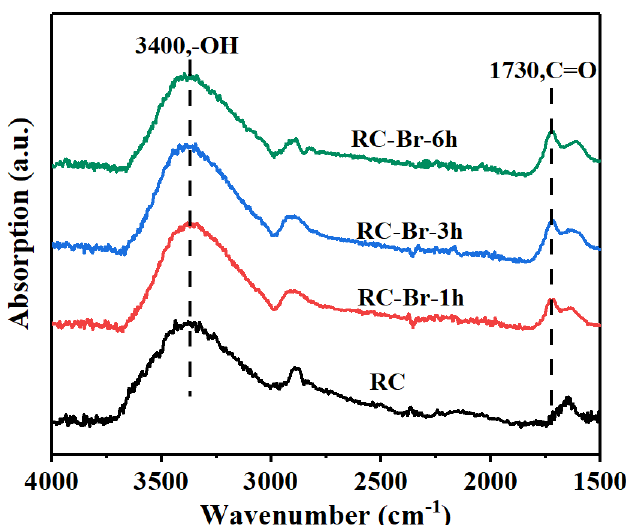
Figure 3. FTIR spectra of RC membranes and 2-BIBB-initiated RC membranes with different reaction times.